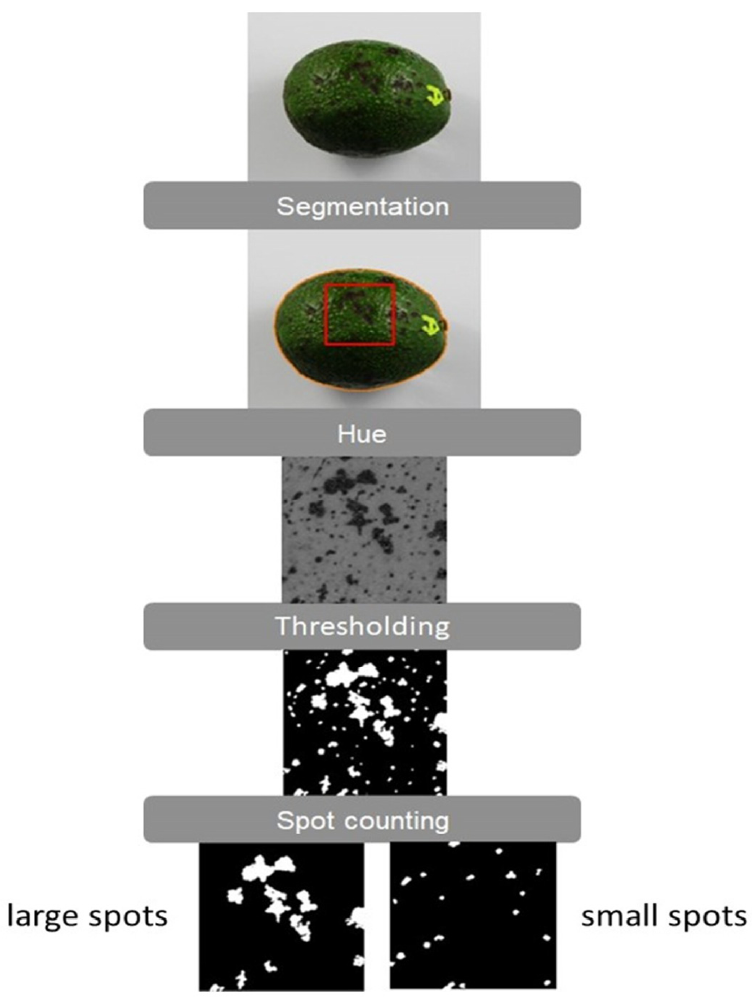
Figure 4. Segmentation and spot counting (“large spots” corresponding to “black spot” and “small spots” corresponding to “lenticel damage”) in each avocado using image analysis. ( A ) First image corresponds to the input.